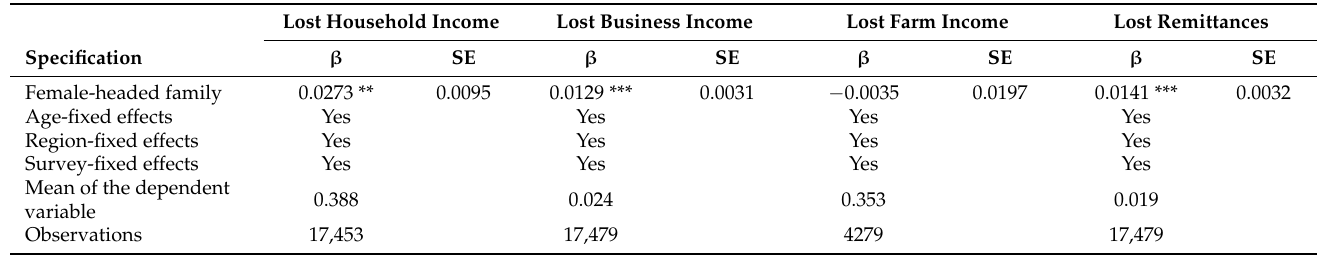
Table 5. The effect of SARS-CoV-2 pandemic on lost incomes in